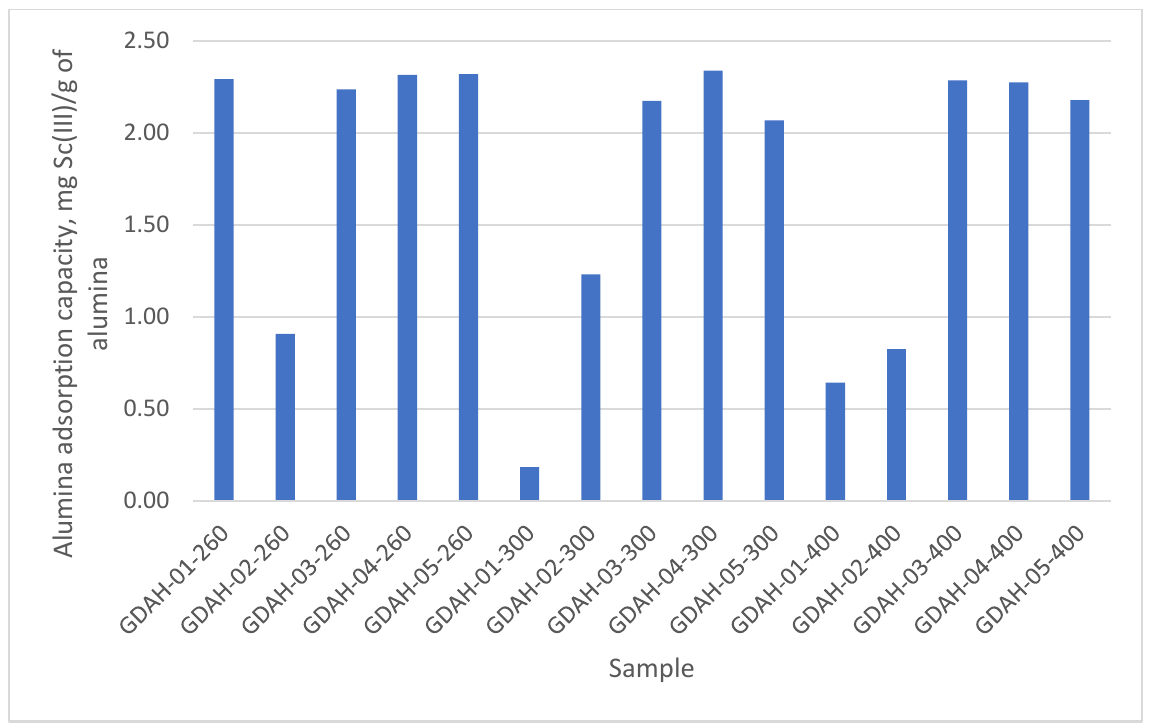
Figure 2. Preliminary scandium adsorption test on low-temperature-activated alumina products.